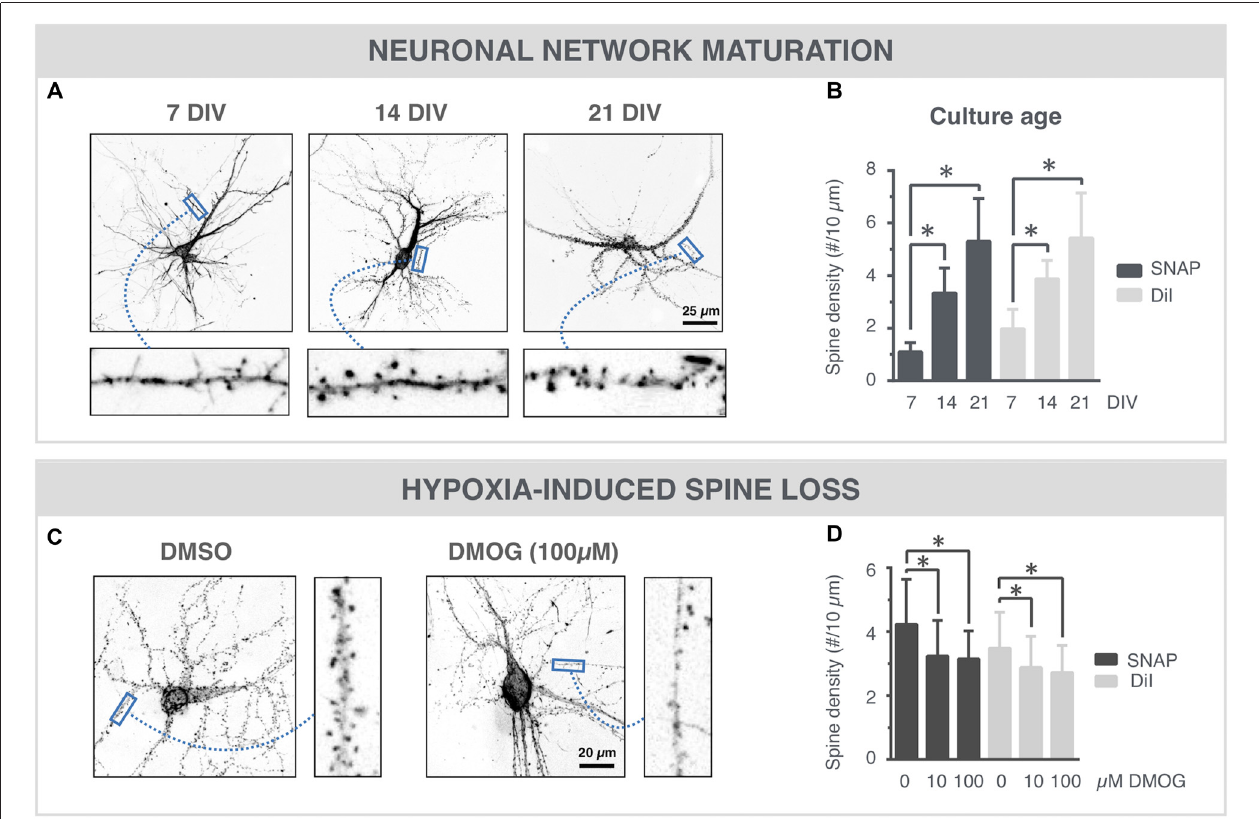
FIGURE 4 | SNAP reveals maturation-dependent and hypoxia-induced changes in spine density. (A) Microscopic images of phalloidin-labeled neurons at 7, 14 and 21 DIV. Spines (arrows) can be discerned at different time points. (B) Quantification shows a time-dependent increase in spine density and a similar trend for SNAP and DiI labeling ( ∗ p < 0.05 in Dunn all pairs test, see Table 1 for p -values). (C) Phalloidin-labeled neurons with and without DMOG treatment to mimic hypoxic conditions. (D) Quantification of spine density after SNAP or DiI labeling shows a reduction in spine density upon 24 h DMOG treatment ( ∗ p < 0.05 in Steel test, see Table 1 for p -values). Microscopy images have been inverted for clarity.